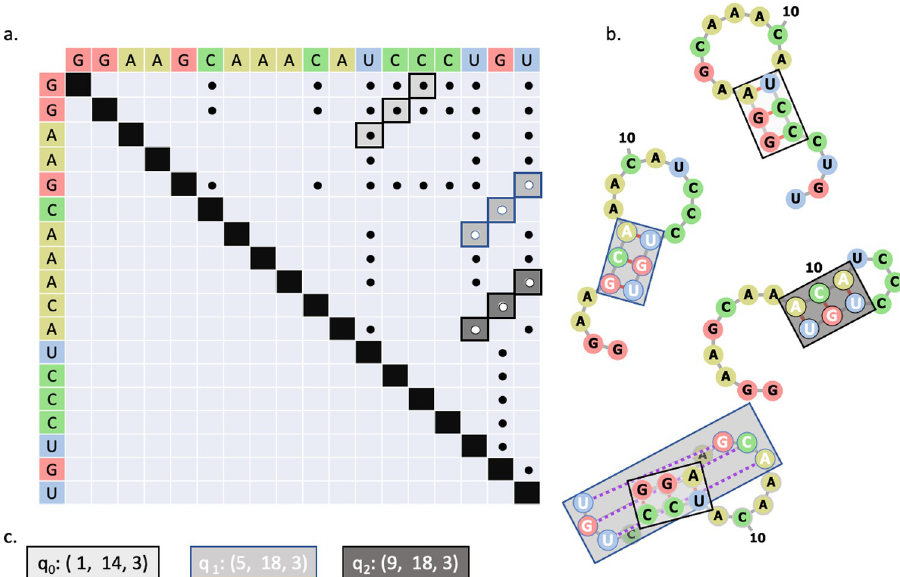
Fig 1. (a) Matrix representation of potential base pairs. Stems are highlighted in shades of gray and outlined in black or blue. The colors serve only to help distinguish the stems. (b) Structural representations of stems. Grey lines indicate covalent bonds, red lines indicate base pairing, and dashed purple lines represent base pairs in a pseudoknot configuration. The color of the boxes map to the stems identified in (a). (c) Each possible stem is assigned to a qubit on the quantum device. If the qubit returns “1”, then the associated stem is included in the RNA secondary structure. Otherwise, the stem is